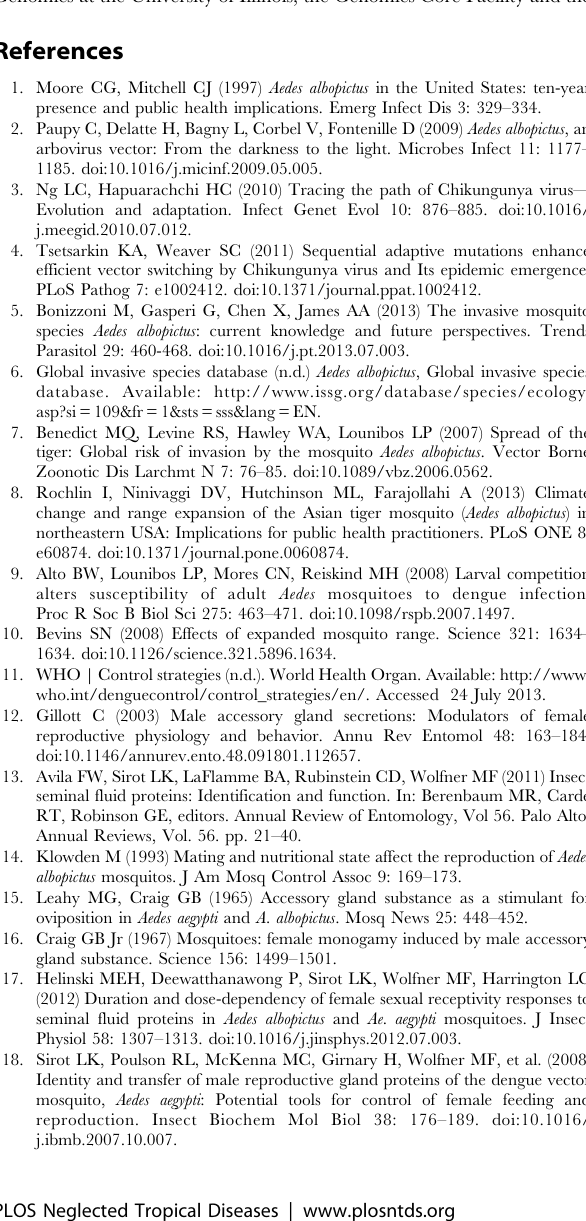
Table S7 Estimation of dN/dS for Ae. albopictus putative seminal fluid proteins with putative orthologs in Ae. aegypti. (XLS) Table S8 Codeml analyses for Ae. albopictus putative seminal fluid proteins with putative orthologs in Ae. aegypti , Cx. quinquefasciatus and An. gambiae . (XLSX) Text S1 Description of methods used for transcriptome sequencing, assembly, and generation of Ae. albopictus reproductive tract predicted protein database. (DOCX) Text S2 Identification of additional putative Ae. albopictus seminal fluid proteins by searching mass spectra against the Ae. aegypti genome.